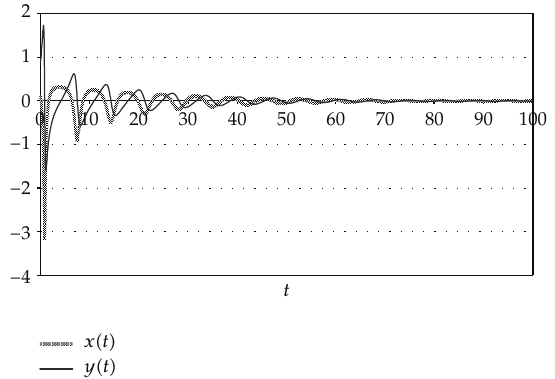
Figure 2: x (cid:2) 0 (cid:3) (cid:6) 0.1, y (cid:2) 0 (cid:3) (cid:6) 0.9, a (cid:6) 0.1, b (cid:6) 0.9, alpha (cid:6) 0.9.